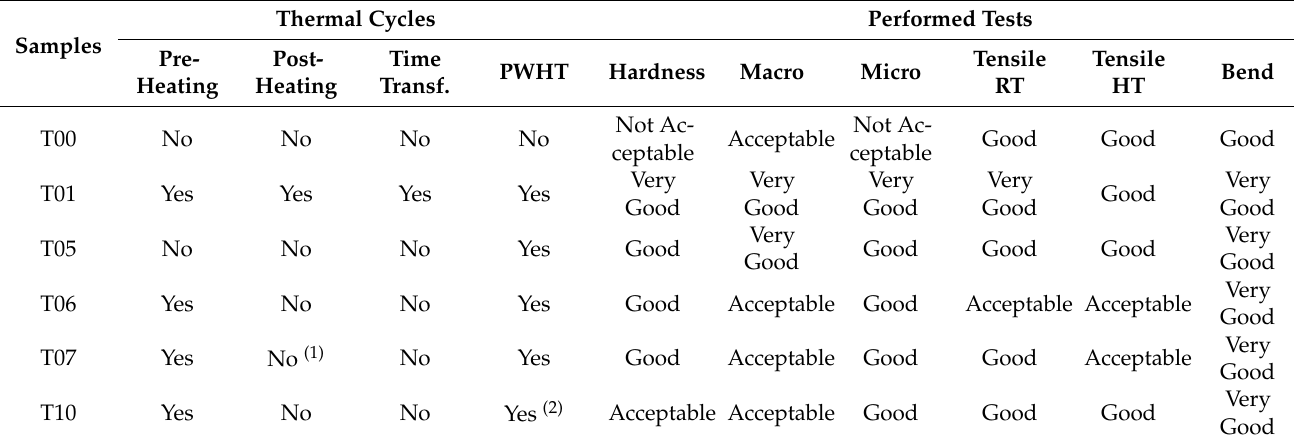
Table 10. Summary of the thermal cycles applied and corresponding results by test type.